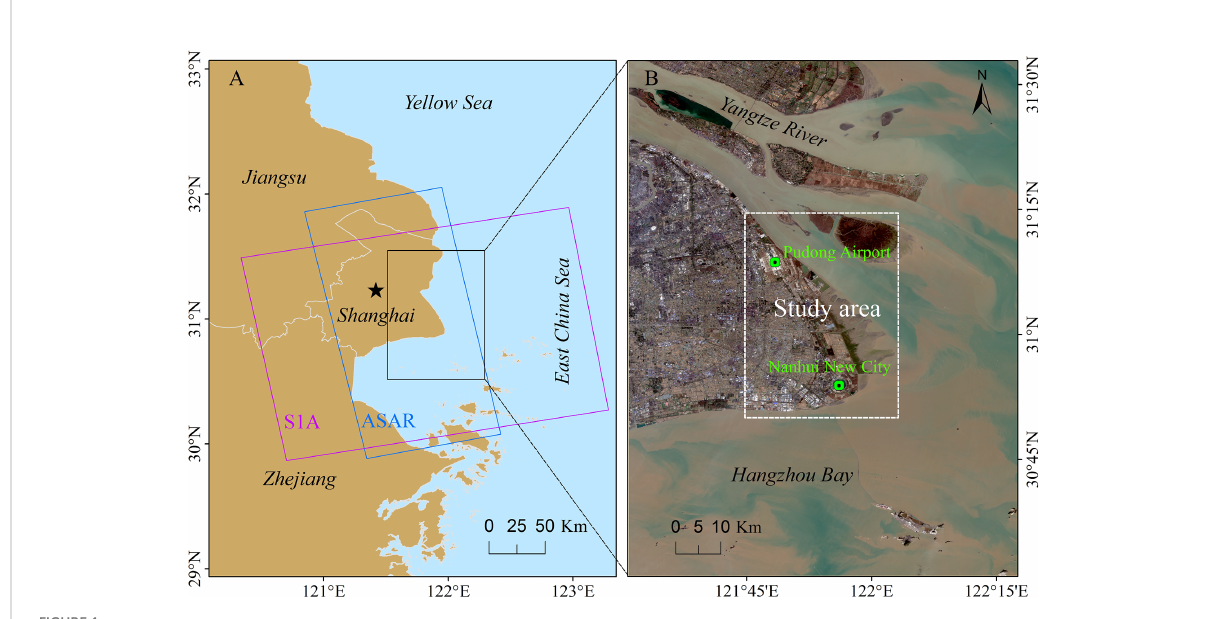
FIGURE 1 (A) Location of Shanghai city with the coverage of the datasets used; and (B) the study area outlined by a white